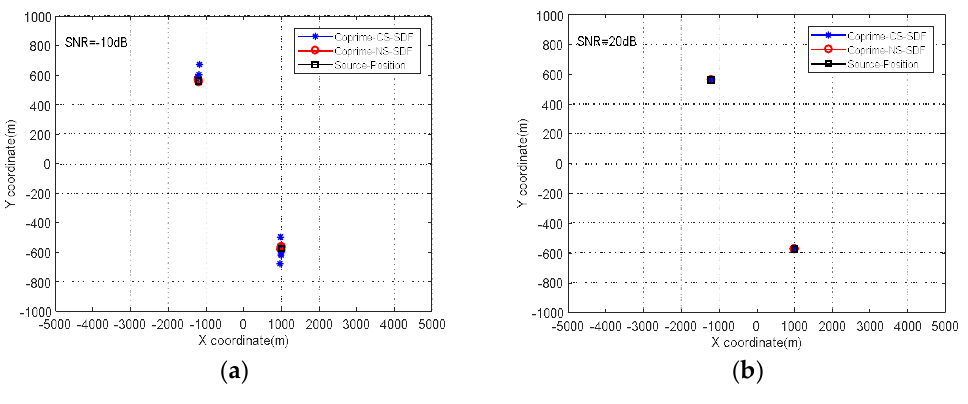
Figure 8. Positioning results of the proposed algorithm ( a ) SNR = −10 dB ( b ) SNR = 20 dB. Simulation 2. RMSE comparison of MCA-DPD, SDF, two-step localization, and CRLB under different SNRs.